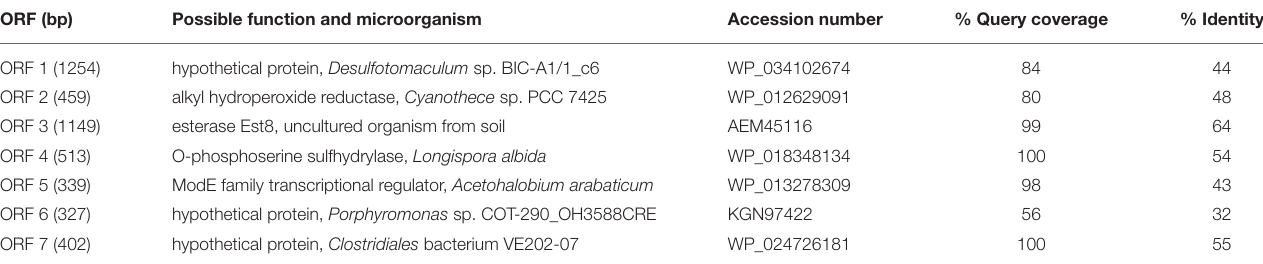
TABLE 2 | Best hits by BLASTP search against non-redundant protein (nr) database for ORFs detected in the insert from FOS4A subcloned in pUC19. ORF